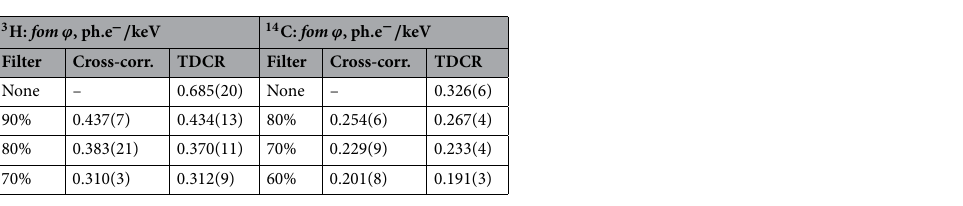
Table 1. Comparison of the fom obtained by cross-correlation and TDCR measurements with various levels of 3 14 grey filters for H and C LSC